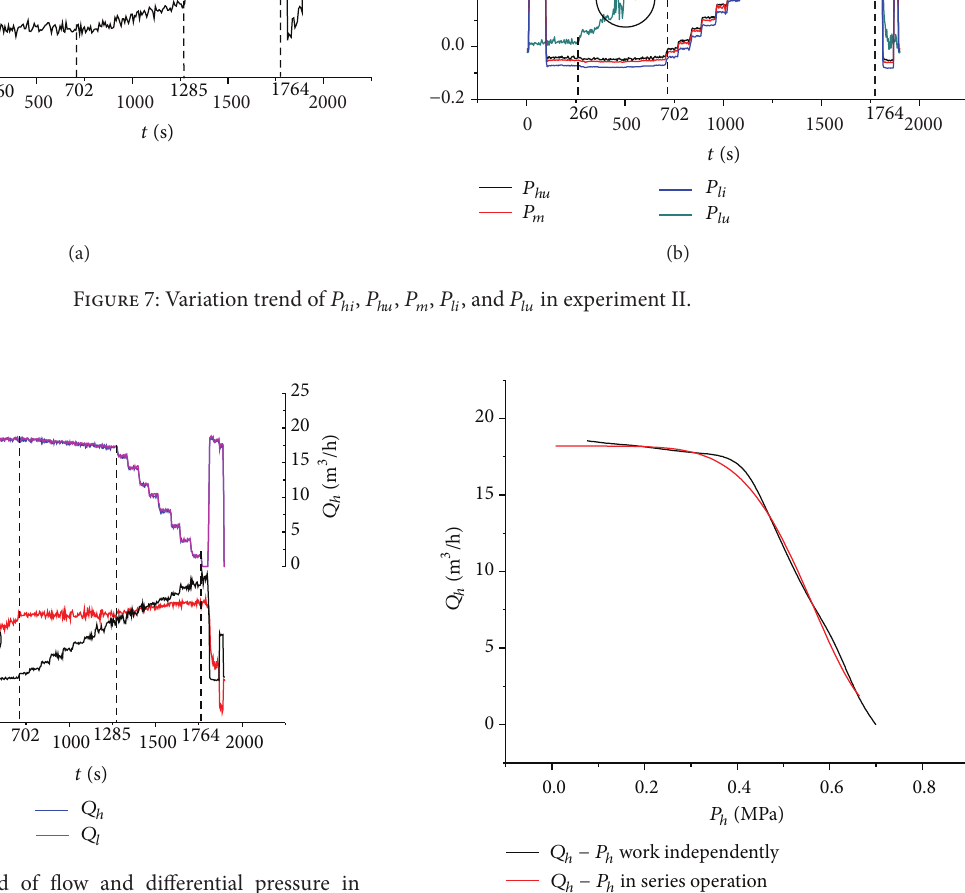
Figure 9: Comparison of performances of sliding vane